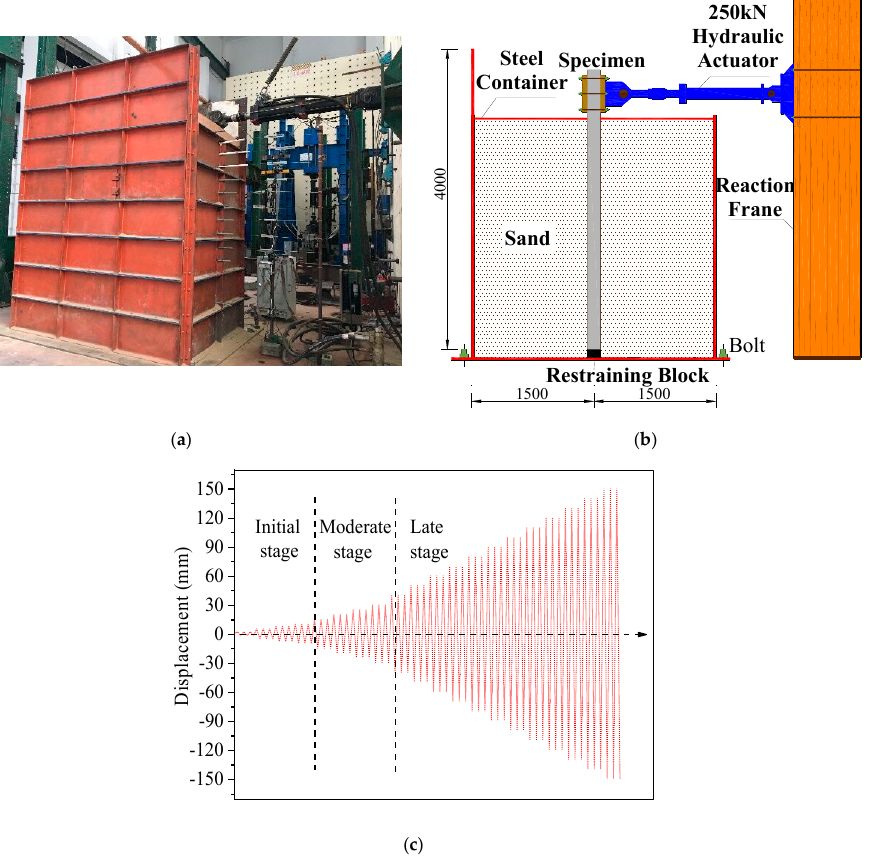
Figure 7. ( a ) Overall view of the test setup. ( b ) Detail of the test setup. ( c ) Loading protocol of the test.